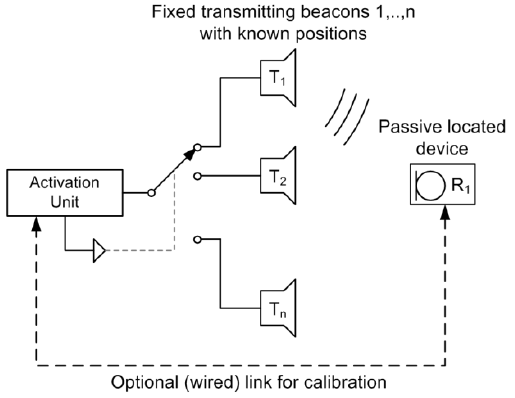
Figure 1. Basic localization of sensor nodes by Ultra Sound ( LOSNUS ) system